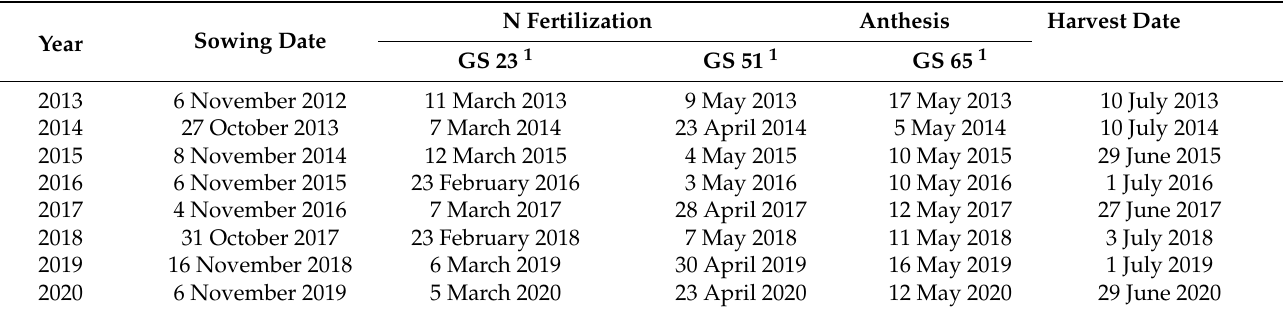
Table 1. Main trial information for the field experiments conducted in Cigliano (NW Italy) in the 2012–2020